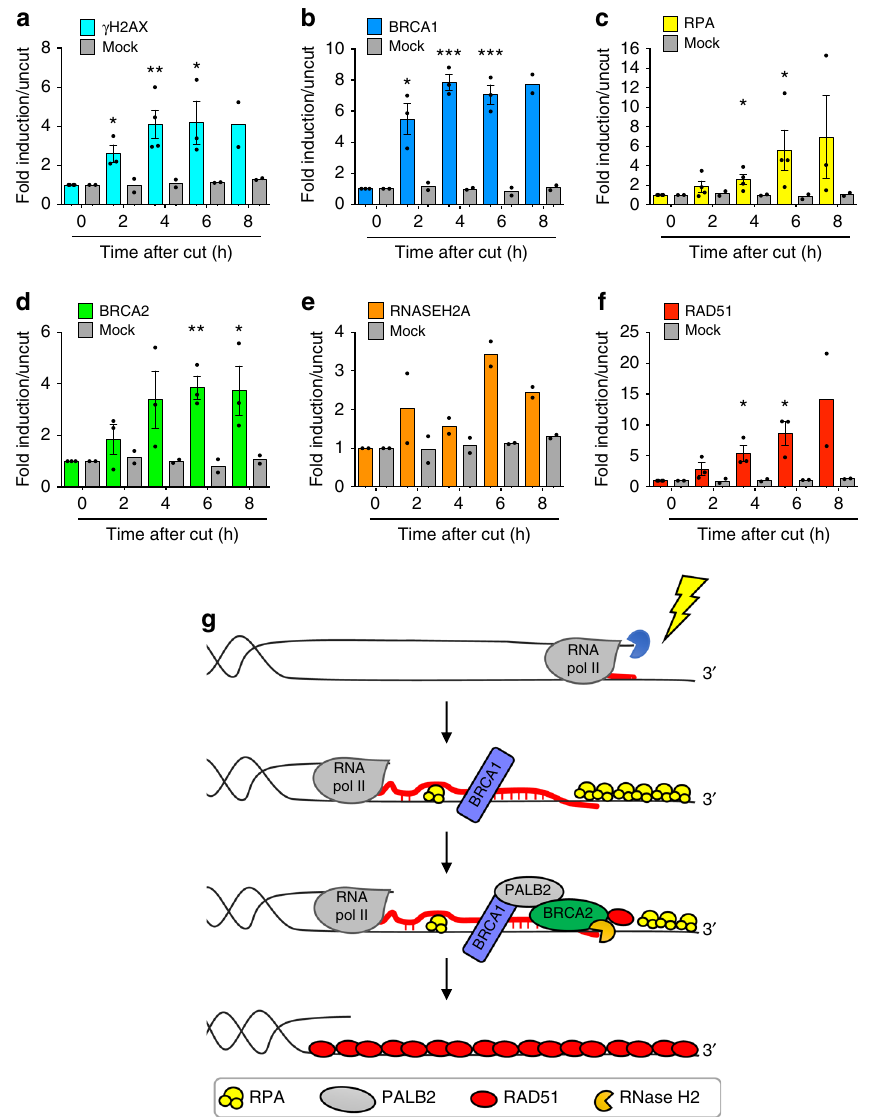
Fig. 7 RNase H2 recruitment to DSBs occurs al later time-points after DSB induction. Bar graphs showing fold induction of a γ H2AX, b BRCA1, c RPA, d BRCA2, e RNase H2, and f RAD51 signals at the nongenic AsiSI site analyzed in Fig. 1d. Lines represent mean ± s.e.m. ( n ≥ 2 biological replicates). * P < 0.05, ** P < 0.01 (two-tailed Student ’ s t test). g Model of DNA:RNA hybrid dynamics at DSBs. Source data are provided as a Source Data replaced with fresh media and cells were harvested 3 days after. In both cases, Next, coverslips were washed twice in PBS 1× and fi xed and stained as described in before transfection, the ASO solution was incubated at 95°C for 5 min and chilled the “ Immuno fl uorescence and imaging analysis ” section. on ice for 5min to prevent the formation of secondary structures of the oligonucleotides. ASO sequences are listed in Supplementary Data 2. Inhibition of RNA polymerase II transcription . RNA polymerase II transcription was inhibited by treatment with α -amanitin (50 μ g/ml) (Sigma-Aldrich) or 5,6- dichloro-1- β - D -ribofuranosylbenzimidazole (DRB, 50 μ M) (Sigma-Aldrich), respectively dissolved in deionized water and Dimethyl sulfoxide (DMSO). Immediately after adding the drugs, HeLa cells were irradiated (5 Gy) and then fi xed 6 h later. For α -amanitin treatment, before adding the drug to the medium, cells were mildly permeabilized with 2% Tween 20 in phosphate-buffered saline (PBS) 1× for 10 min at room temperature (RT). RT-qPCR analysis of the levels of c-FOS, a short-lived RNA speci fi cally transcribed by RNA pol II, was used to monitor the ef fi cacy and speci fi city of the drugs. RNase H treatment . U2OS cells were plated on coverslips and irradiated (2Gy). One hour later cells were permeabilized with 0.2% Tween 20 in PBS 1× for 10 min at RT. After two washes in PBS 1×, each coverslip was incubated for 30 min at RT with 15 U RNase H (USB corporation) diluted in 200 μ l PBS with 5 mM MgCl 2 64 .